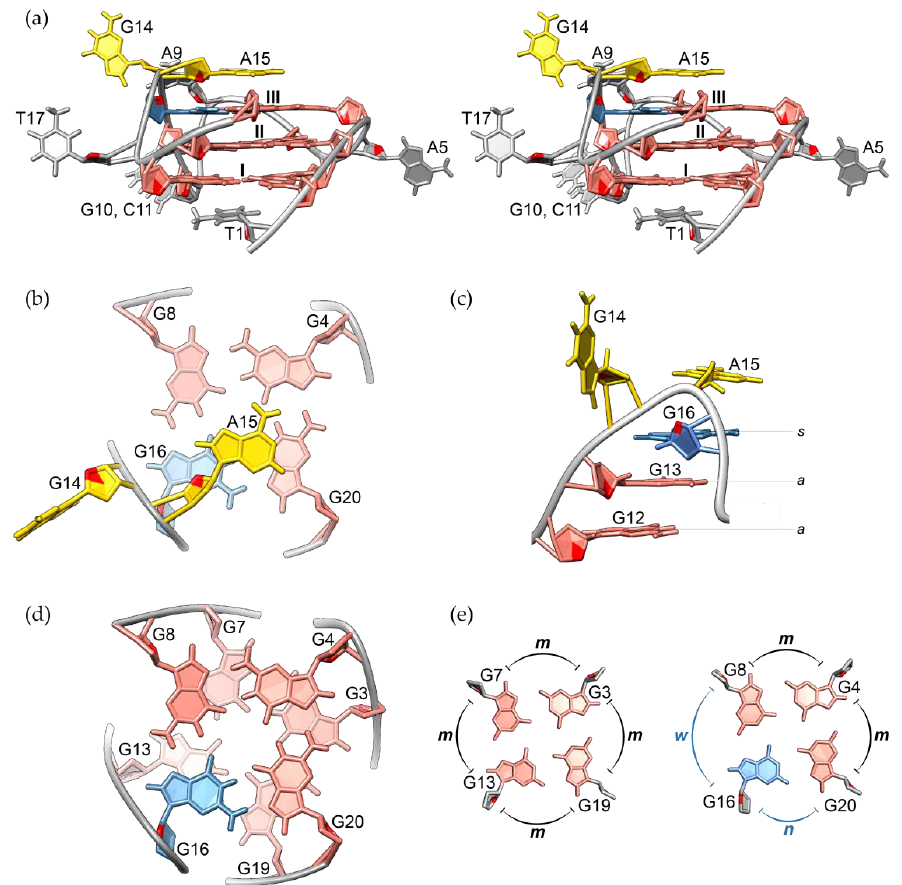
Figure 3. ( a ) Stereo-view of the lowest-energy structure of RAN1*. G-quartets are marked I, II and III. ( b ) Stacking interactions between A15 and G-quartet III. ( c ) Side-view of the G14-A15 bulge and G12-G13-G16 residues forming a discontinuous G-tract. ( d ) Stacking interactions between G-quartets II and III. ( e ) Comparison of groove widths between G-quartets II and III. Letters m , w , and n denote medium, wide and narrow grooves, respectively. Residues with anti and syn glycosidic conformations are colored salmon and light blue, respectively. Bulge residues G14 and A15 are in yellow, while other loop residues are grey. O4′ atoms are red.